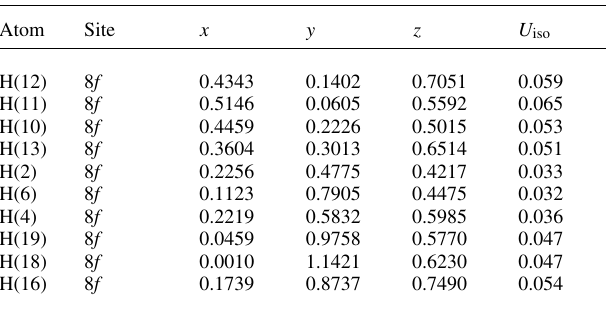
Table 2. Atomic coordinates and displacement parameters (in Å 2 )